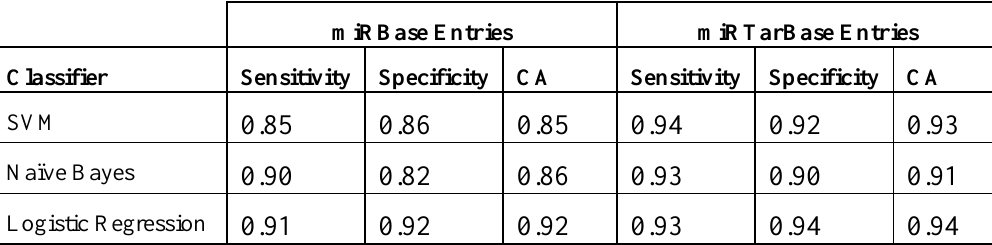
Table 1: Classification of miRNA hairpins and pseudo hairpins using Orange Canvas. SVM, Naïve Bayes, and Logistic Regression were used to compare performance of miRBase as positive data and miRTarBase as positive